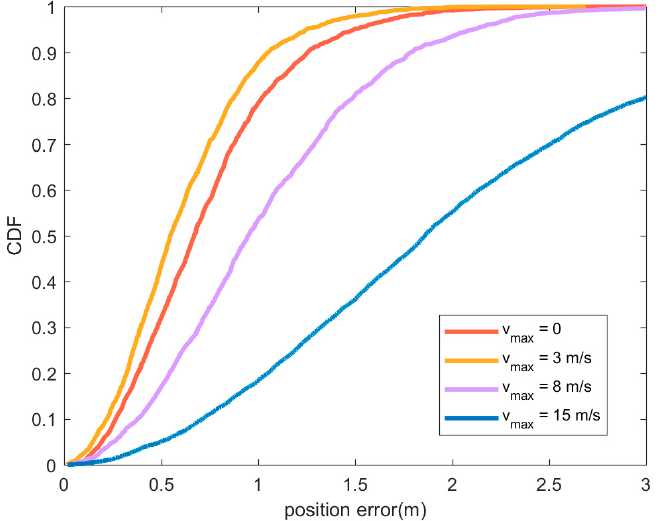
Figure 8. CDF of position error under different maximum node speed v max . In the figure, the red line represents the position error CDF when all nodes are static, the orange line represents v max = 3 m/s, and the purple line represents v max = 8 m/s. The blue line indicates the situation where v max = 15 m/s. In all cases, anchor node is static, the nodes to be located conform to the uniform distribution with the maximum speed v max , and the direction of movement is